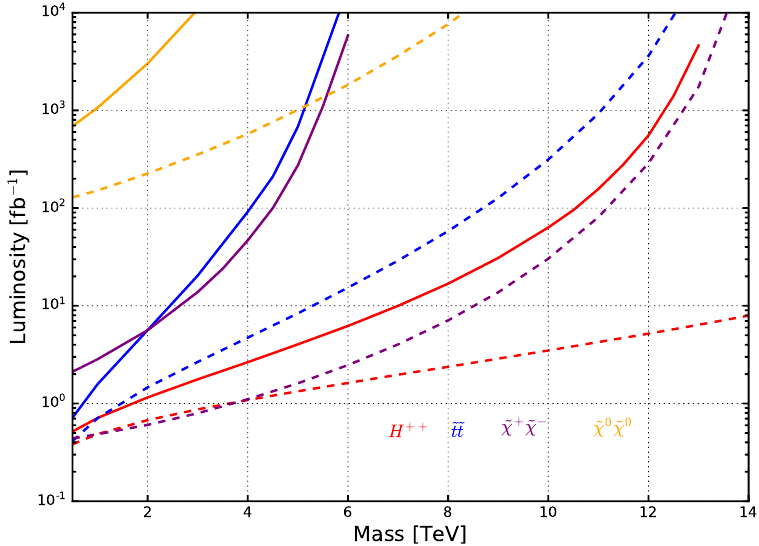
Figure 16 . Required luminosity [fb] for a 5 (cid:27) discovery of H ++ (red) in the GM model; ~ t ~ t (blue), ~ (cid:31) + ~ (cid:31) (cid:0) (purple), and ~ (cid:31) 0 ~ (cid:31) 0 (yellow) from in the MSSM, using VBF in 30 TeV (dashed) muon